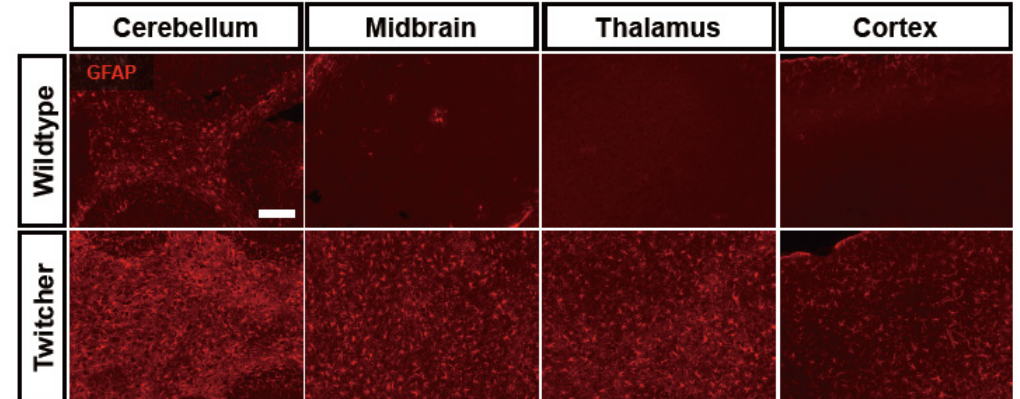
Figure 1. Widespread astrogliosis is a prominent neuropathological feature of the twitcher mouse brain. Representative pictures show immunohistochemically labeled glial fibrillary acidic protein (GFAP)+ astrocytes (red) in several regions of the brain, including cerebellum, midbrain, thalamus, and cortex in wildtype C57BL/6 (upper row) and in age-matched twitcher mice (bottom row). Note that highly fibrous GFAP immunoreactivity is observed with greater intensity throughout the twitcher mouse brain, compared to wildtype mouse. Scare bar = 250 μ